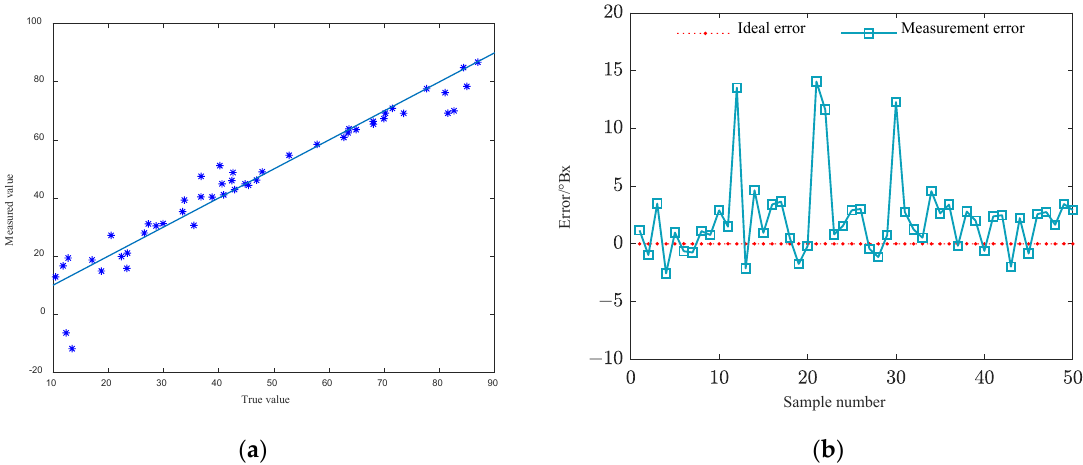
Figure 11. Measurement results of syrup brix based on mixed dielectric model in the independent test set. ( a ) Measurement results of brix; ( b ) Measurement errors of brix.